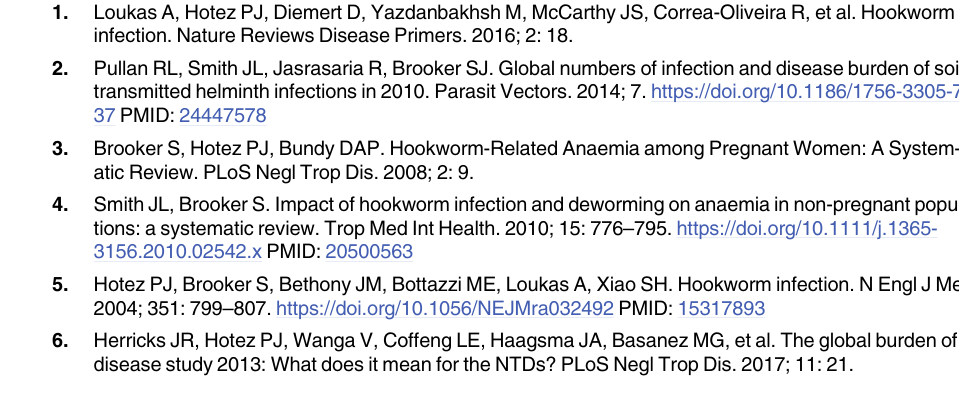
S1 Fig. qRT-PCR primer efficiency tests for Syrian hamster cytokine primer sets on sple- nocyte total RNA. Shown are threshold cycle (Ct) values regressed by Log10 serial dilutions. Amplification factors and efficiencies were calculated using qPCR Efficiency Calculator (Thermo